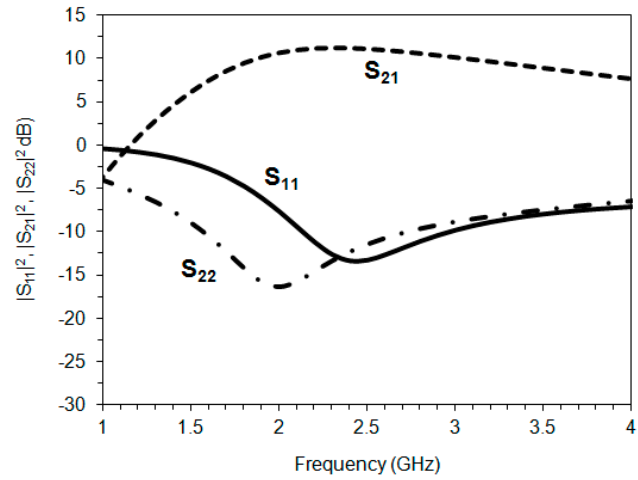
Figure 6. Simulation results of S 11 , S 21 , and S 22 of the proposed PA IC.